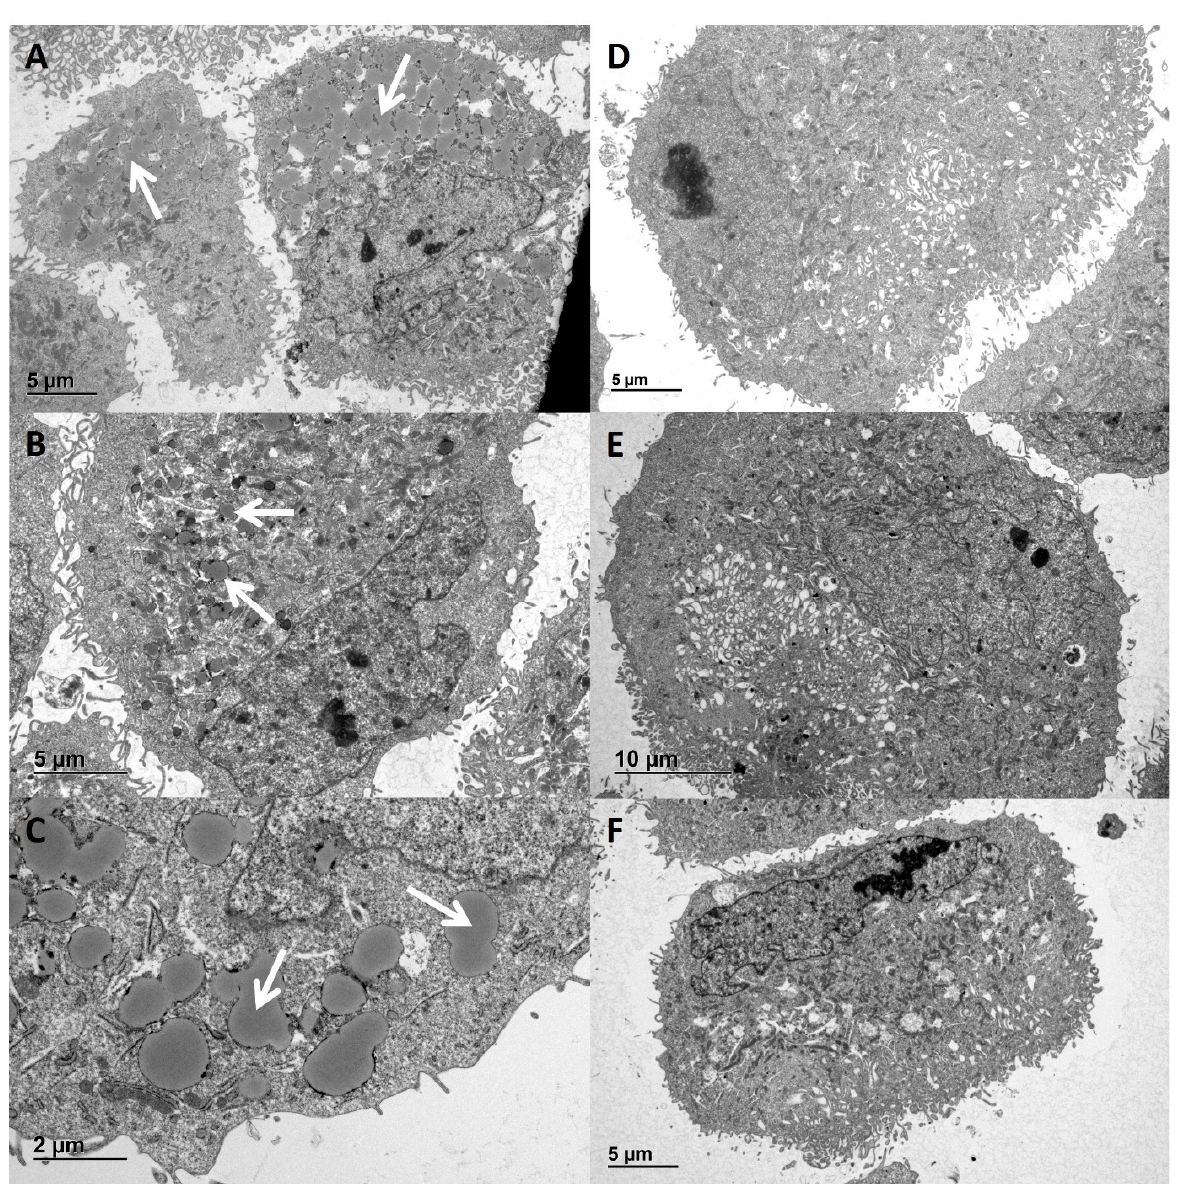
Figure 5. Lipid droplet resembling structures in hPod exposed to active disease FSGS plasmas. hPod differentiated in T25 culture flasks (Corning) were exposed to FSGS plasmas. Electron microscopy images of hPod exposed to ( A ) active disease plasma nat1A, ( B ) post-transplant recurrence plasma rec1B, ( C ) nat1A plasma zoomed in, ( D ) remission plasma nat1B, ( E ) post-transplant remission plasma rec1C, ( F ) healthy plasma. The presence of lipid droplets resembling structures is indicated by white arrows.